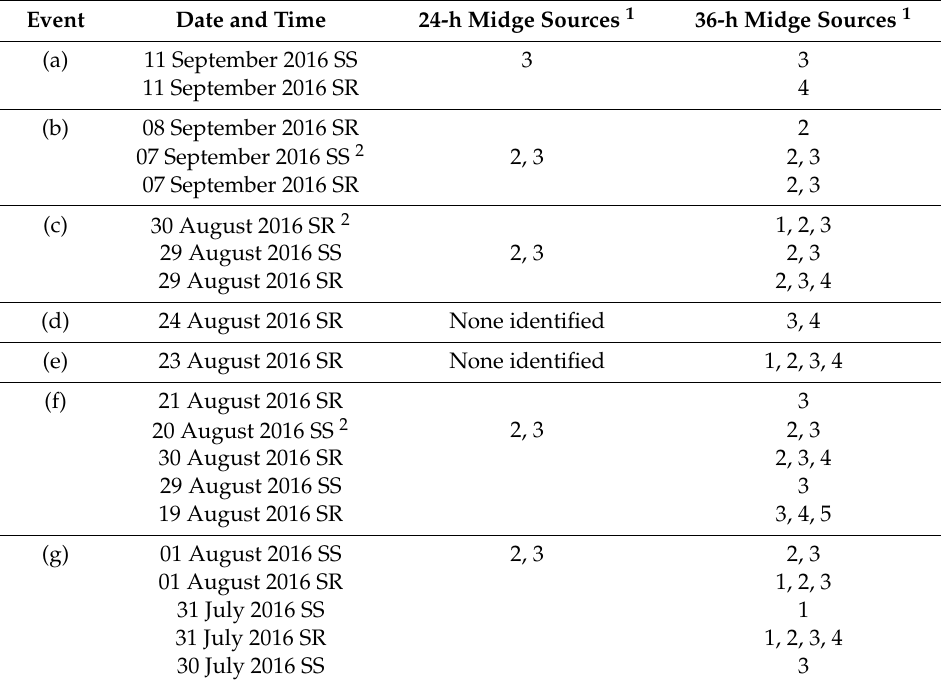
Figure 3. Maps of the near-surface history of air passing over the Larnaca region, aggregated over the period 21 July to 18 September 2016. Air parcels with a lifetime of ( a ) 24 h and ( b ) 36 h are shown. Table 2. Date and time of NAME midge dispersal simulations that suggested potential incursions into the Larnaca region from Syria, Lebanon or